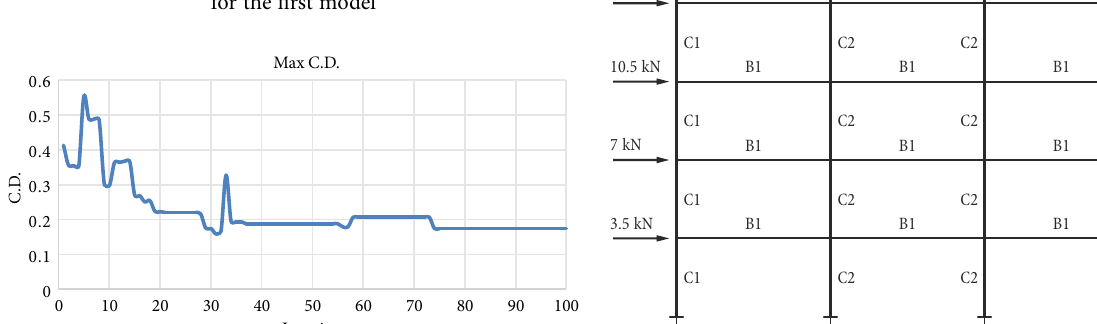
Fig. 7. The population number in the first front for the first model